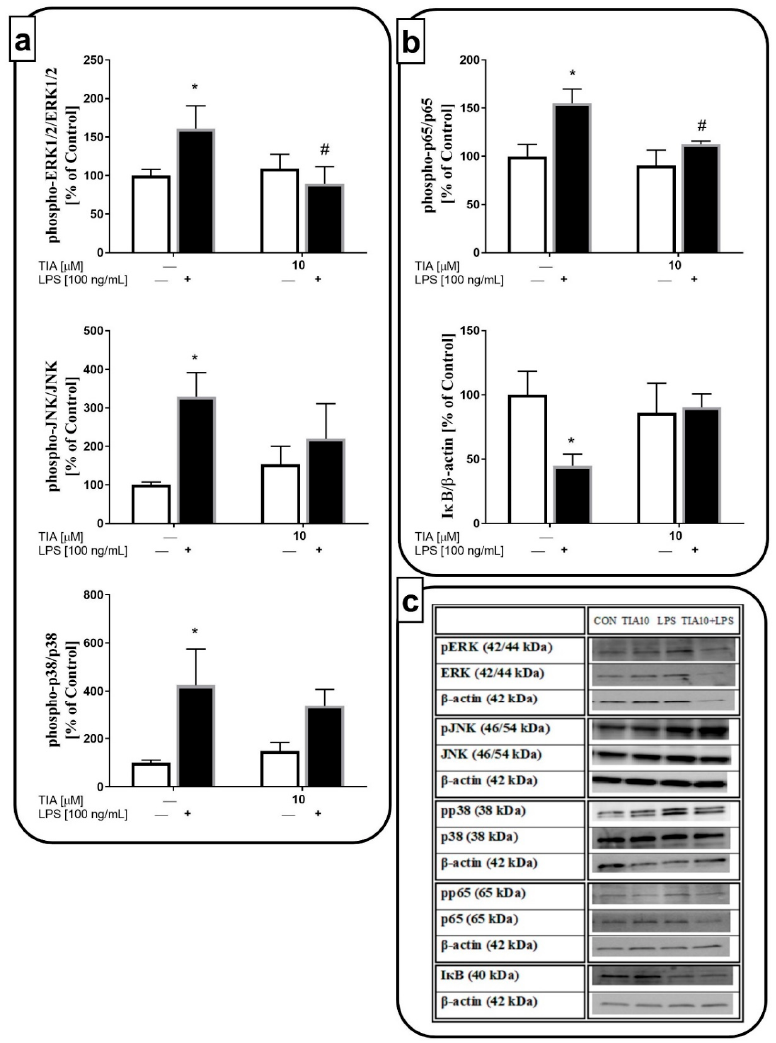
Figure 6. The effect of tianeptine (TIA) on ( a ) mitogen-activated protein kinases (MAPK) and ( b ) nuclear factor kappa-light-chain-enhancer of activated B cells (NF- κ B) pathways measured using western blot analyses in vehicle- and LPS-treated primary microglial cells; ( c ) representative immunoblots. Microglial cells were pretreated with tianeptine (TIA; 10 μ M) for 30 min, and then with lipopolysaccharide (LPS; 100 ng/mL) for 30 min. The data were evaluated as a ratio of the phosphorylated form of each kinase/total amount of kinase and presented as the mean ± SEM percentage of control (vehicle-treated cells) from independent experiments ( n = 6 in each group). The results were statistically evaluated using two-way analysis of variance (ANOVA) with a Duncan post-hoc test to assess the differences